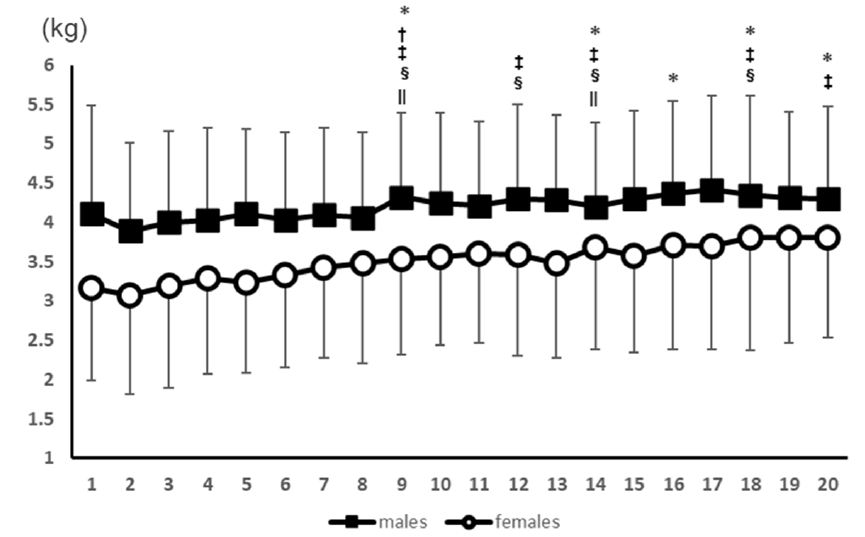
Figure 2. Results of the PPT values for the knee extensors for 20 consecutive measurements. *: Significant difference from the 2nd measurement. †: Significant difference from the 3rd mea- surement. ‡: Significant difference from the 4th measurement. §: Significant difference from the 5th measurement. ||: Significant difference from the 6th measurement.